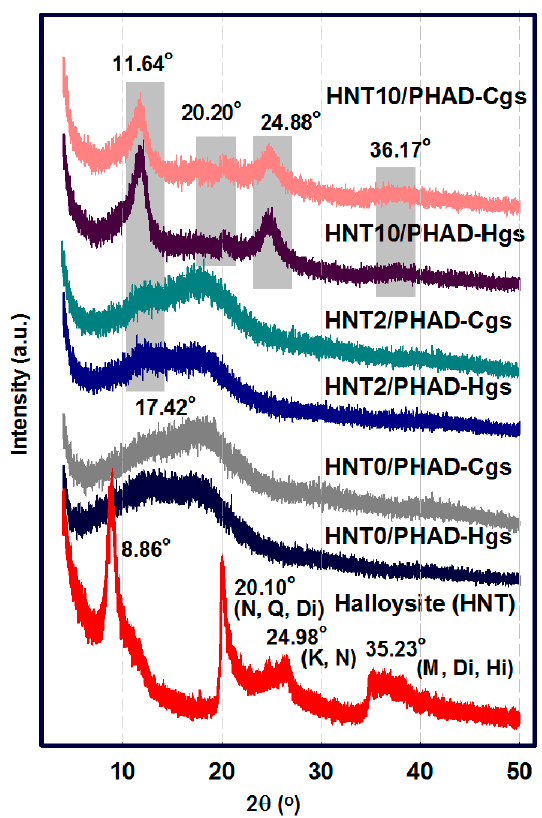
Figure 4. XRD pattern of pristine HNT, HNT-free hydrogel and cryogel (HNT0/PHAD-Hgs and -Cgs), and ternary hybrid hydrogel and cryogel (HNT2/PHAD and HNT10/PHAD-Hgs and -Cgs) samples prepared at HNT content 0.50% and 2.80% ( w / v ).